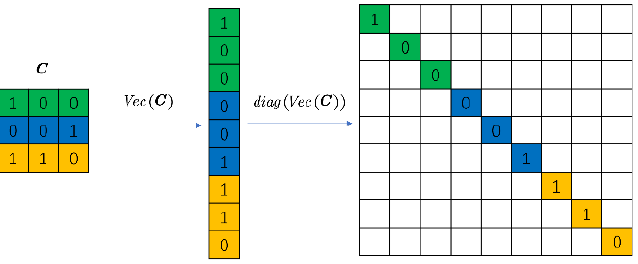
Figure 5. Example when mask is a 3 × 3 matrix. Different colours represent different rows of .